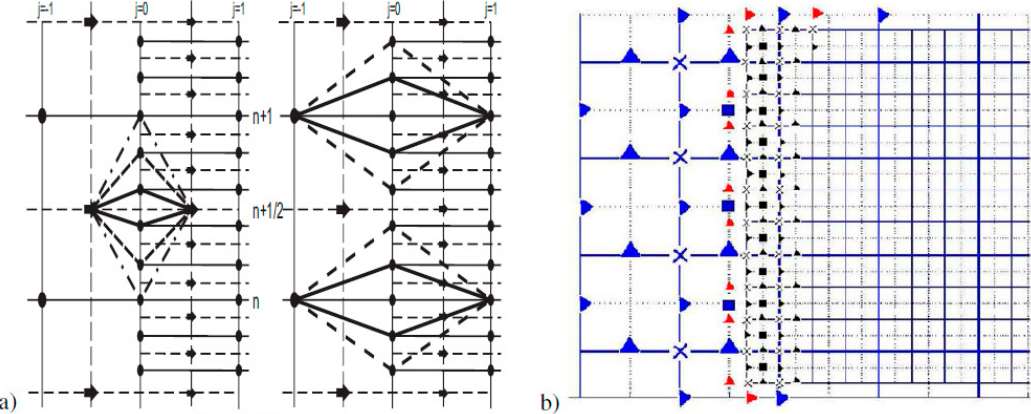
Figure 2. The mutual disposition of fine and coarse grids. ( a ) In time, ( b ) In space.